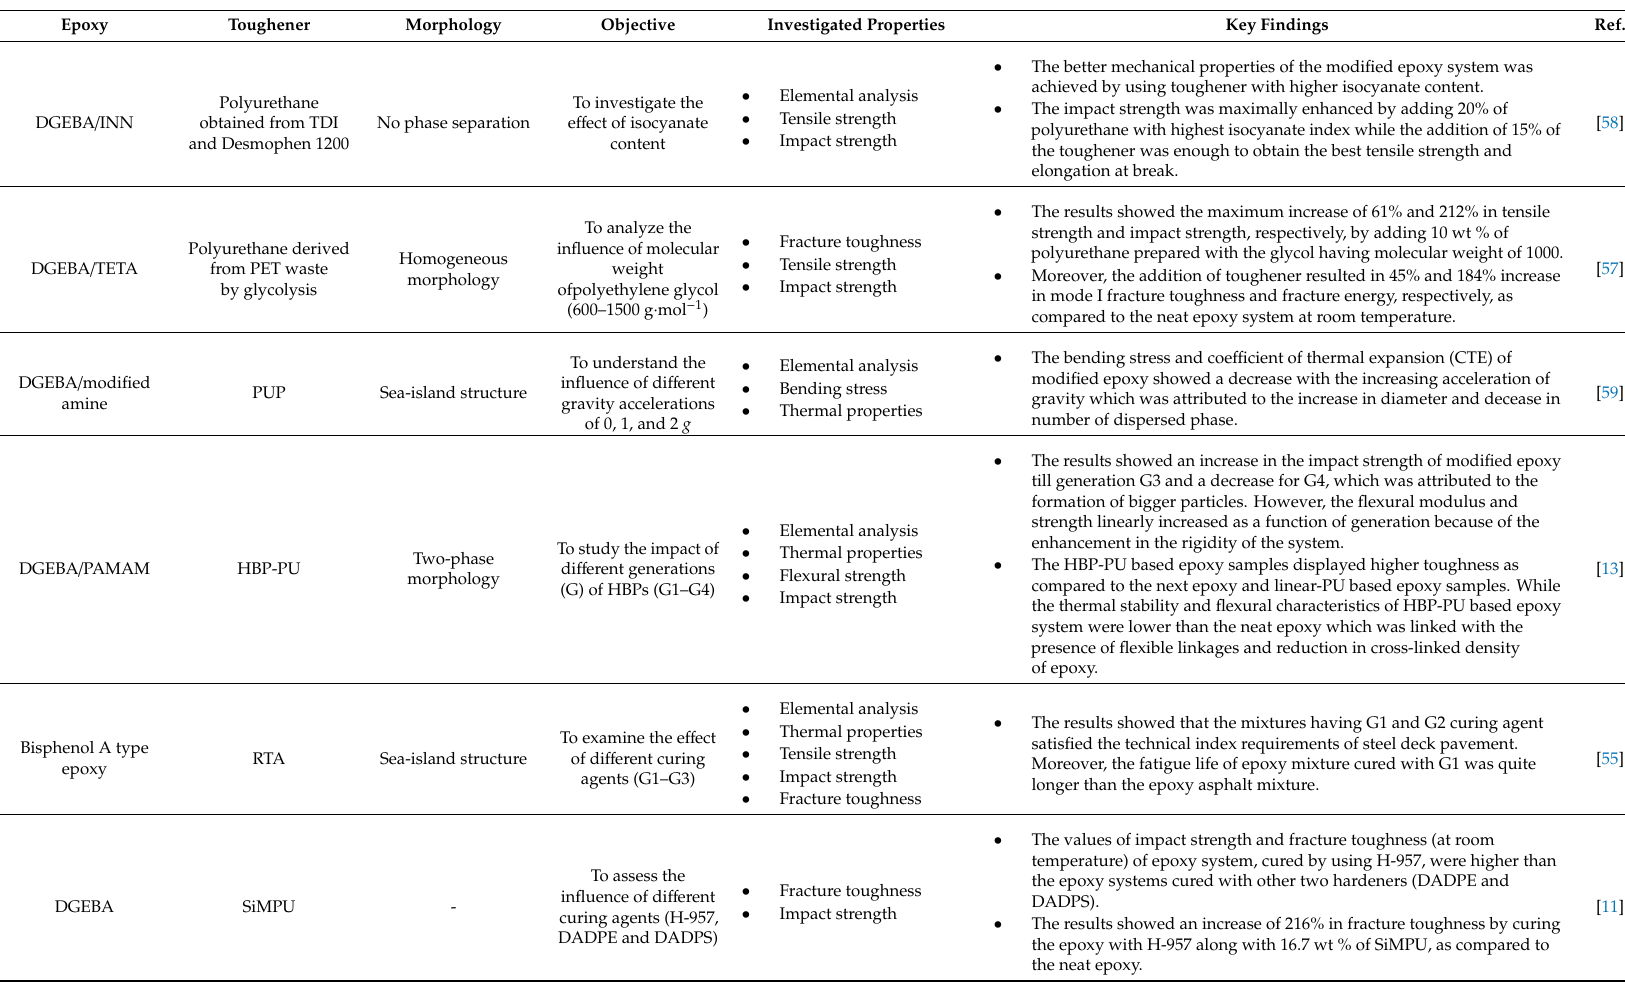
Table 2. Brief summary of di ff erent IPN based systems investigated in literature for epoxy modification as a function of di ff erent